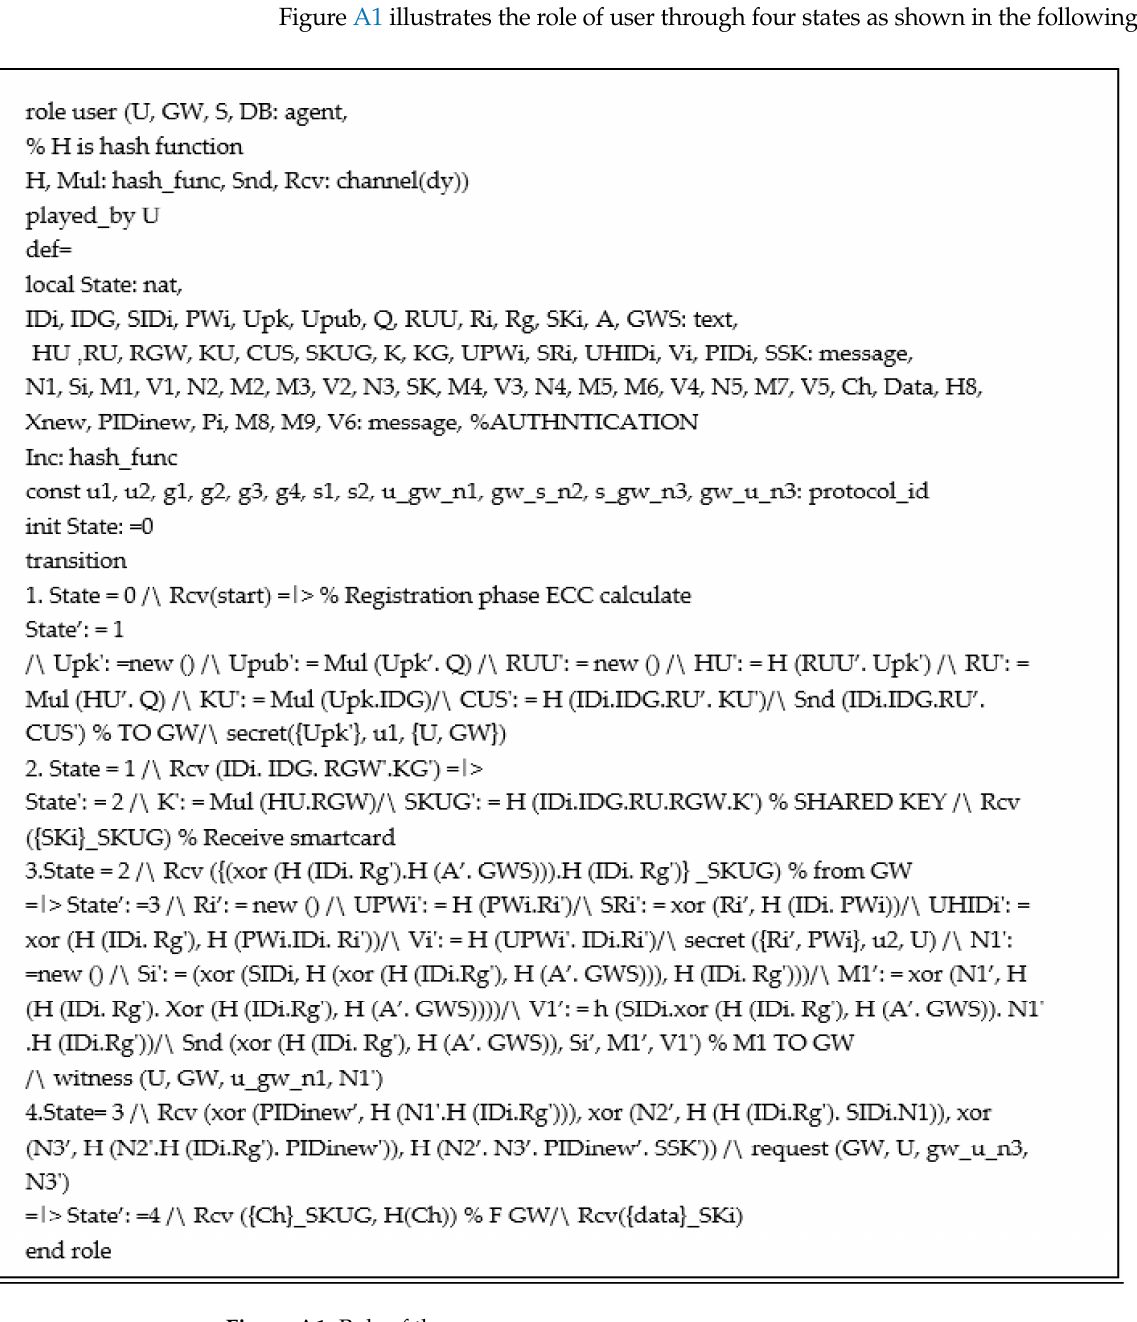
Figure A1. Role of the user.